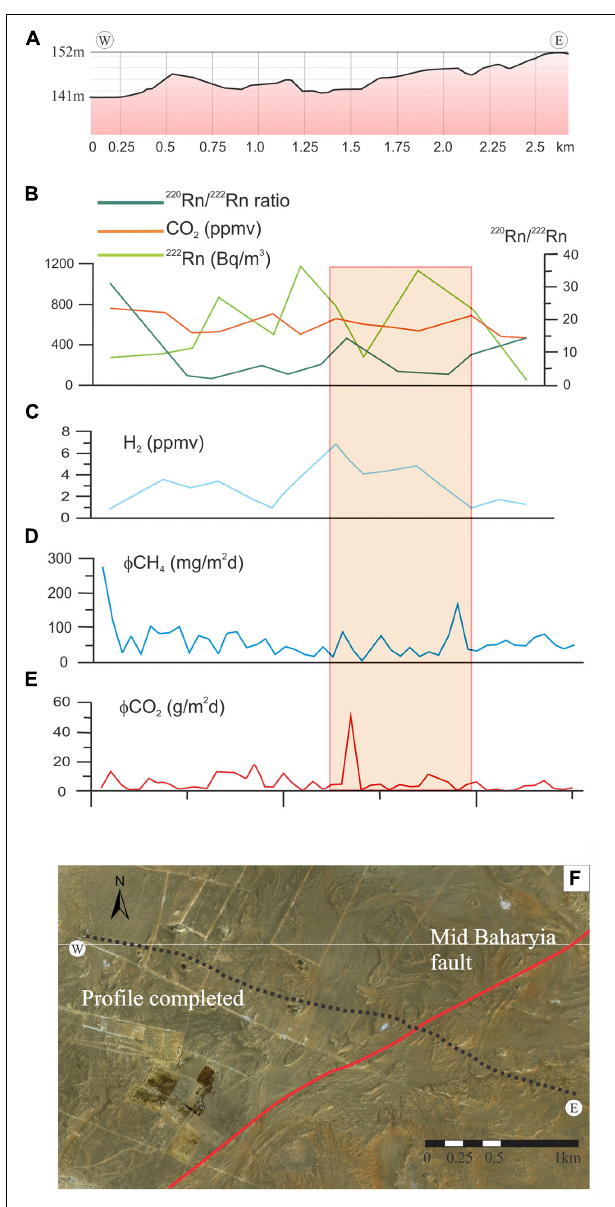
FIGURE 7 | (A) Vertical exaggerated topographic altitude of the NW-SE profile (black line); spatial distribution of (B) CO 2 and 222 Rn concentrations and 220 Rn/ 222 Rn ratio; 222 Rn peaks are present at the intersection with the master fault ( ∼ 1.9 km), extension fault on the hanging wall ( ∼ 1.2 km). (C) H 2 concentration, (D) CH 4 flux measurements, (E) CO 2 flux measurements. The intersection with the main trend of the master fault (red segment) and strain sector around the fault (light red shaded rectangle) are reported; (F) Google earth image of the NW-SE profile (black points) and fault lineament (red line).